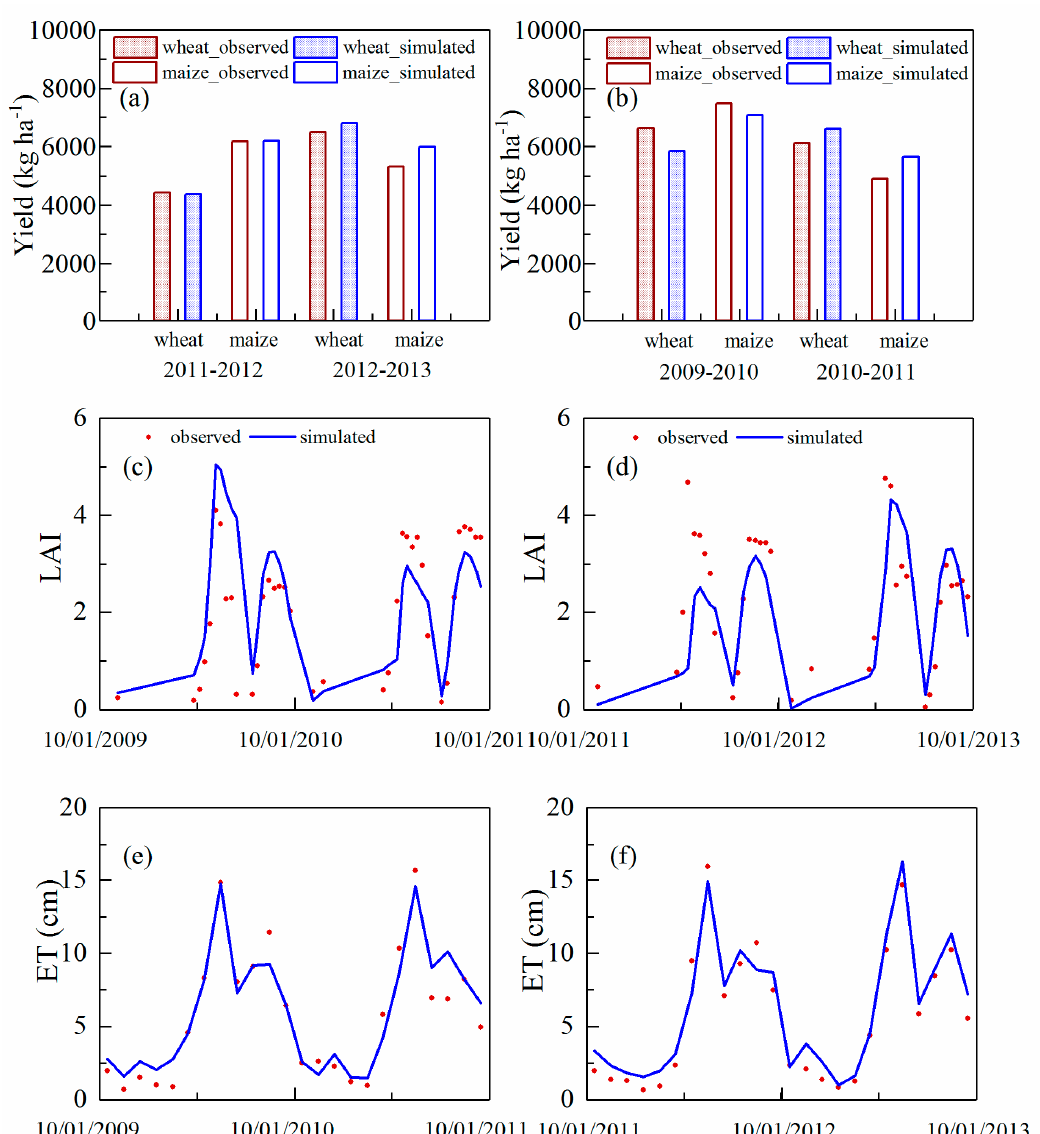
Figure 4. Comparisons of observed and simulated crop yield, leaf area index (LAI), and evapotranspiration (ET) for calibration ( a , c , e ) and validation ( b , d , f ) of winter wheat and summer maize.